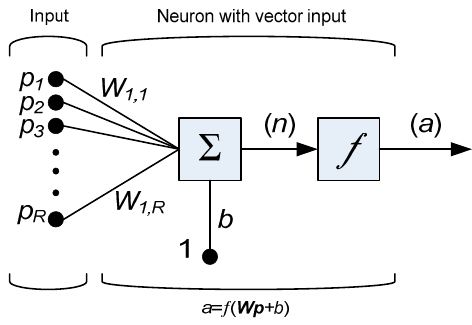
Figure 2. A neuron with a single R-element input vector.